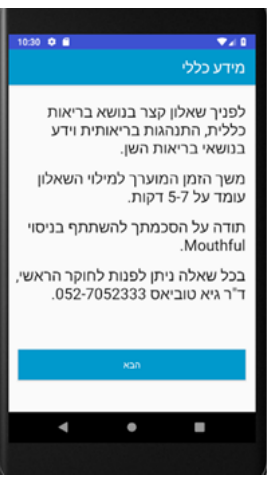
Figure 6. General explanation screen for the patient.